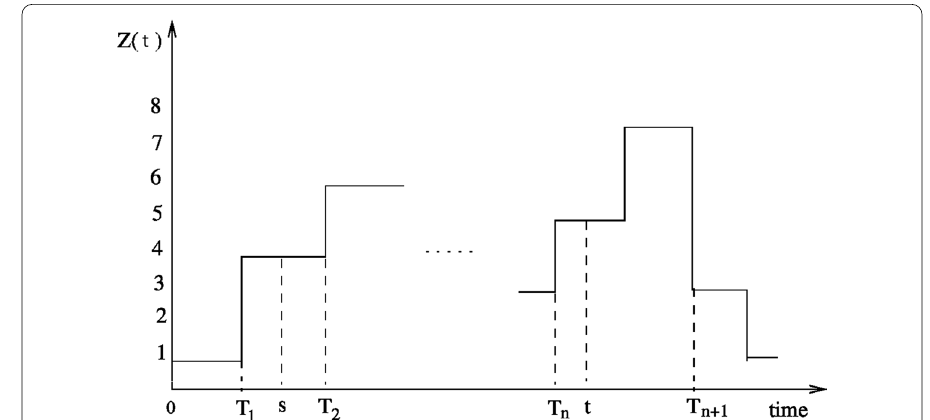
Fig. 6 Sample path of a time non-homogeneous